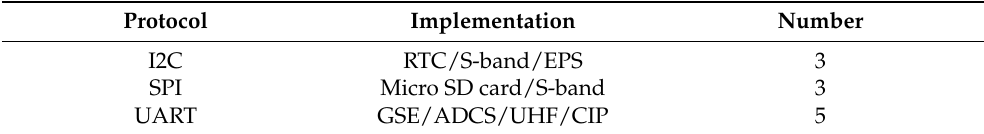
Table 4. IDEASSat data interface.